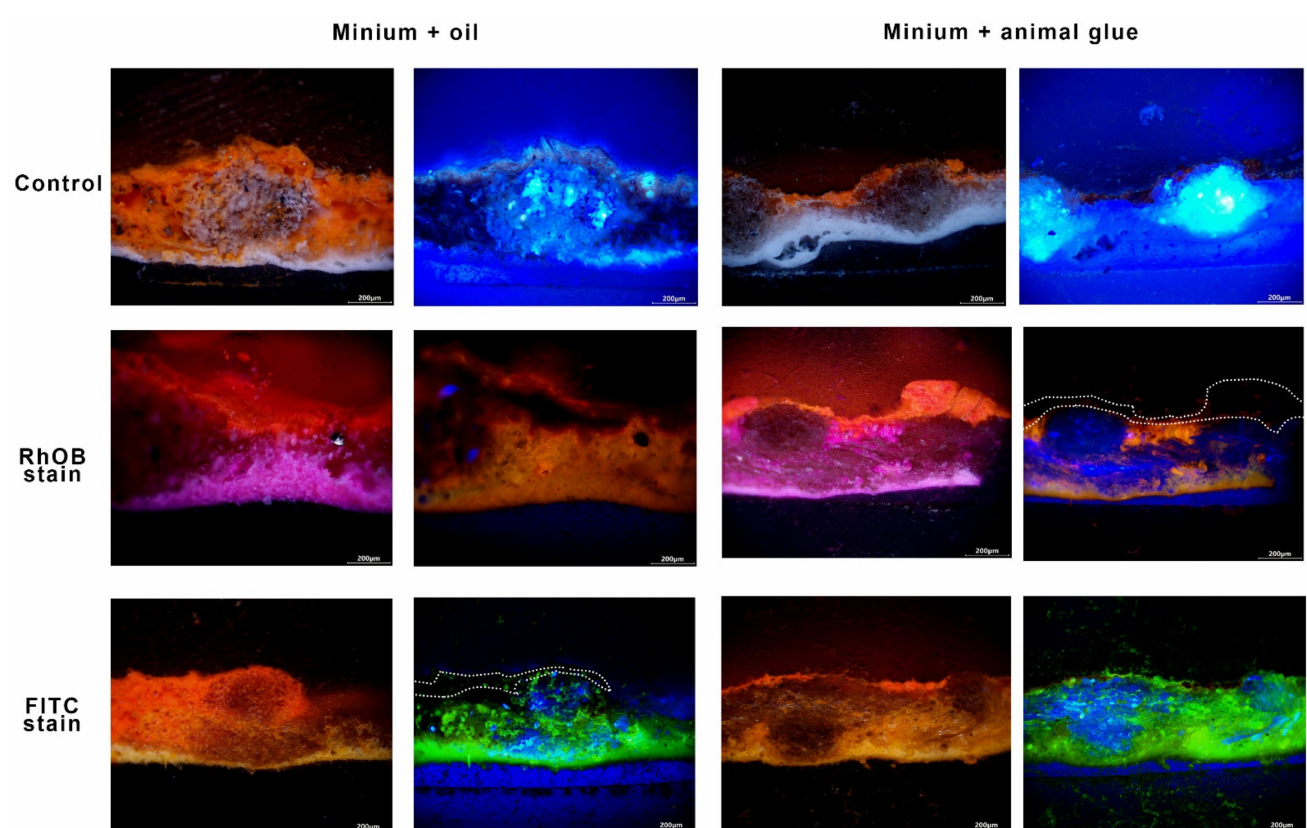
Figure A4. Reference sample showing pictorial layers made using minium mixed with oil and glue on a ground layer made of canvas. The images were obtained under UV light with no RhOB or FITC staining. The dotted line indicates the area of fluorescent